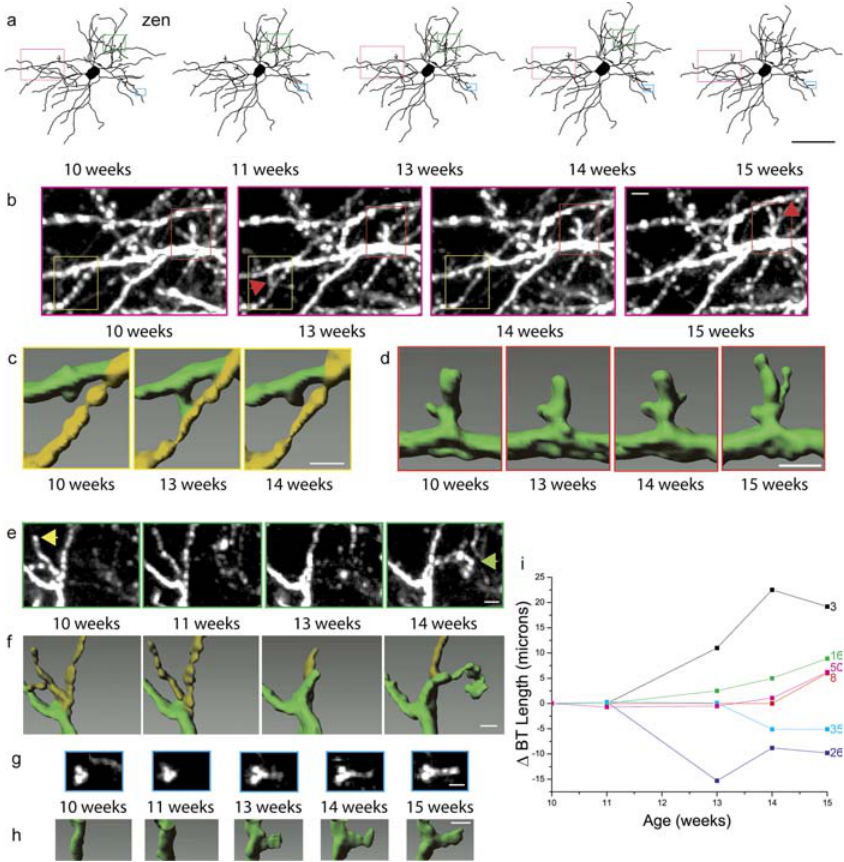
Figure 5. Branch Extensions, Retractions, and De Novo Branch Tip Addition in a Non-Pyramidal Neuron (A) Three-dimensional skeletal reconstructions of the sparsely spinous non-pyramidal neuron ‘‘ zen ’’ from images acquired over 5 wk. (B) High-magnification MZP view of region outlined by purple box in (A). Red arrowheads indicate examples of structural remodeling. Three- dimensional isosurface reconstructions show (C), the elongation and retraction of a spine toward an axon (yellow overlay). (D) Structural change in a cluster of branch tips (#50, far right) (red box in [B]). (E) Higher-magnification MZP view of region outlined by green box in (A). Examples of process retraction and branch-tip (#3) addition are labeled with yellow and green arrowheads, respectively. (F) Three-dimensional isosurface reconstructions of (E) with axon in yellow overlay. (G) MZP view of region outlined by cyan box in (A) shows branch-tip (#16) addition on a different dendrite. (H) Three-dimensional isosurface reconstructions of (G). (I) Plot of change in BTL of dynamic branch tips as a function of age. Number to the right denotes branch tip number. Scale bars: (A), 50 l m; (B–H), 5 l m. DOI: